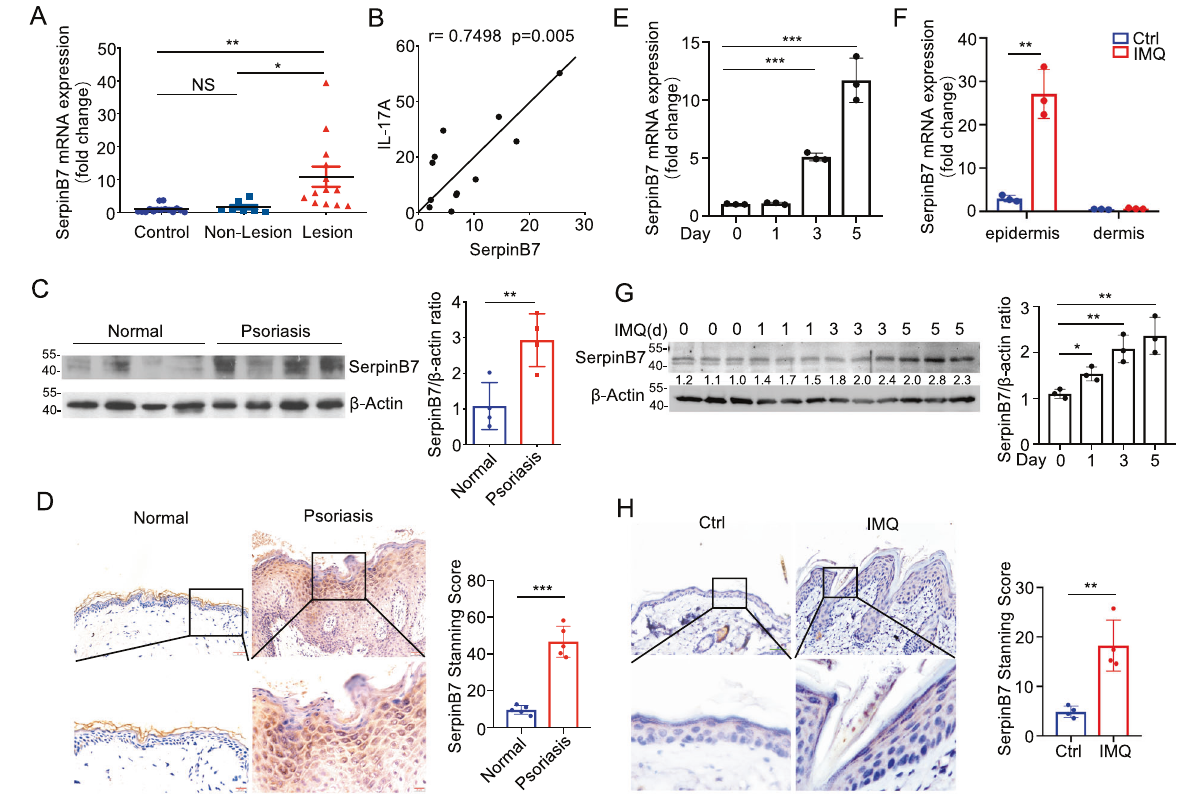
Fig. 1 SerpinB7 is abundantly expressed in epidermal keratinocytes. A Expression of SerpinB7 mRNA in normal ( n = 15), non-lesional ( n = 7), and lesional ( n = 12) human psoriatic skin. B Correlation plot between SerpinB7 and IL-17a in human psoriatic lesion skin. C Immunoblot analysis of protein level of SerpinB7 in skin extracts from normal and psoriasis patients. β -actin was used as an internal control. D Immunohistochemistry staining of SerpinB7 in the skin from healthy and psoriasis patients, scale bar: overviews (100 μ m) and insets (20 μ m) (left), quantitative analysis of four fi elds per mouse (right), n = 5. E Expression of SerpinB7 mRNA of back skin from treated IMQ or control cream mice. F The SerpinB7 mRNA levels was measured by RT-PCR from dissected mice's epidermis and dermis. G Immunoblot analysis of protein level of SerpinB7 in skin extracts from normal and psoriasis patients. β -actin was used as an internal control. H Immunohistochemistry staining the skin from treated IMQ or control cream mice. scale bar: overviews (100 μ m) and insets (20 μ m) (left), quantitative analysis of four fi elds per mouse (right), n = 4. Mean ± SD. * P < 0.05; ** P < 0.01; *** P < 0.001. Two-tailed Student ’ s t -test ( C – F and H ), one-way ANOVA ( A and G ). All the data are representative of three independent experiments.